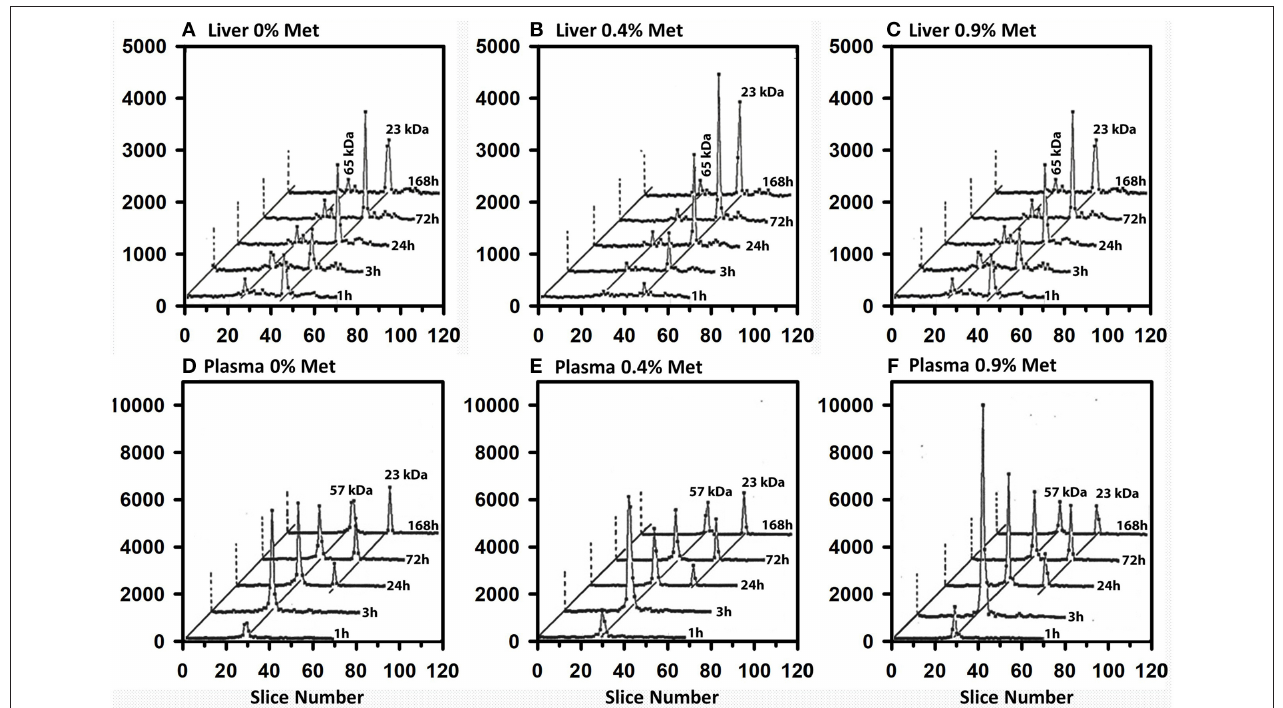
FIGURE 8 | Incorporation of 75 Se from [ 75 Se]SeMet into liver cytosolic (A–C) and plasma (D–F) proteins. Rats were supplemented with 0.2 µ g Se/g diet as selenite in the basal diet containing 0.4% supplemental Met for 50–80 d. For 7 days prior to Se injection, supplemental Met was adjusted to 0, 0.4 or 0.9% D,L-Met; rats were then injected iv with 50 µ Ci of tracer 75 Se-labeled SeMet, and killed at 1, 3, 24, 72, or 168h afer dosing. Liver cytosol and plasma samples were prepared as described in Figures 3 and 4 ( n = 30 total rats). Liver GPX1 is 23 kDa, and the 65 kDa species are similar to the isoenzymes of TXNRD1; plasma SELENOP is 57 kDa and GPX3 is 23